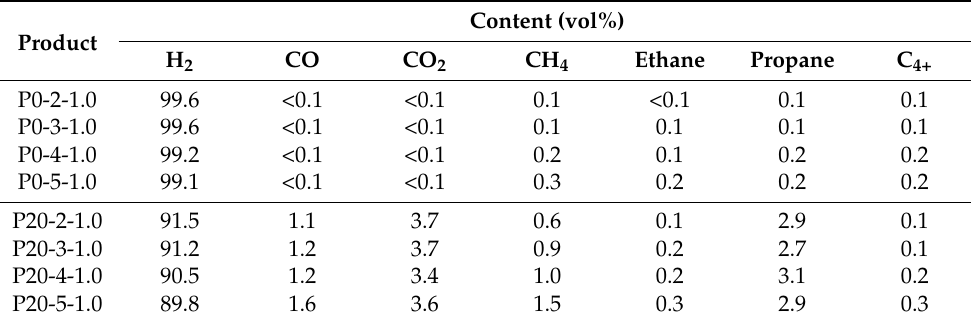
Table 3. The composition of the gaseous products obtained at a WHSV of 1.0 h − 1 .